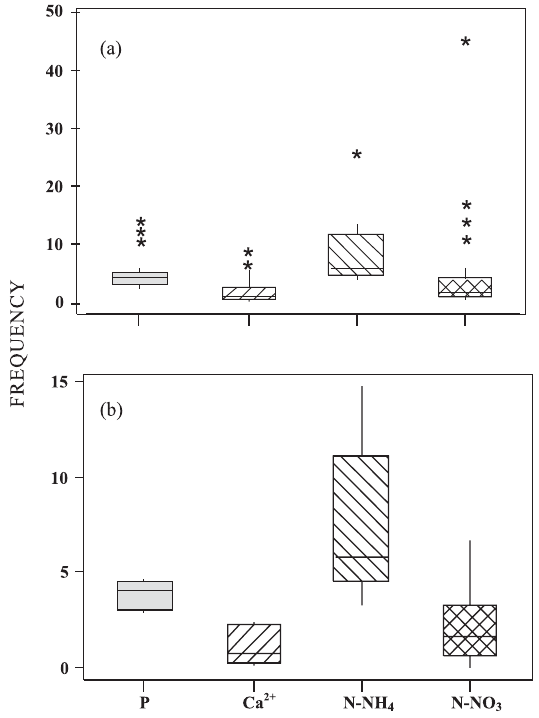
Figure 3. Boxplot of data from the 20–40 cm layer with outlying data (a) and after removal of such data